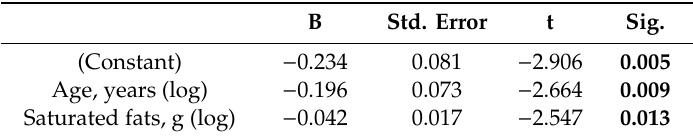
Table 10. Multivariable model predicting the QUICK index, F (2, 90) = 7.271, p = 0.001, adj. R 2 = 0.120. p -values ≤ 0.050 are shown in bold. B Std.